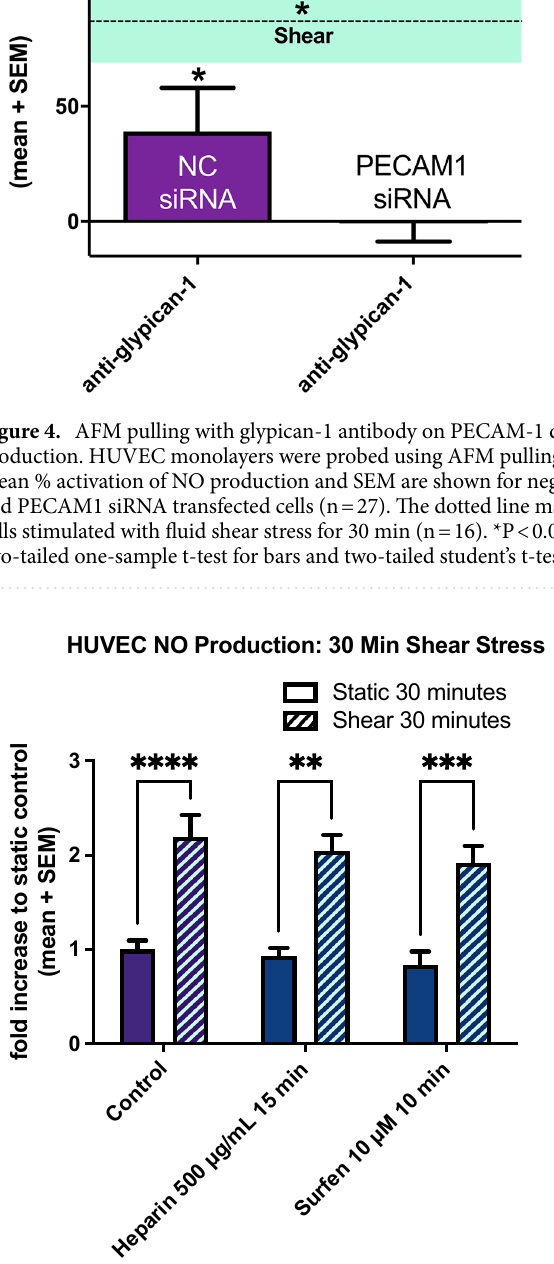
Figure 5. Heparin and Surfen treatment does not affect shear-induced NO production at 30 min in HUVEC. Heparin (500 µg/mL) and surfen (10 µM) were used to treat HUVEC 15 min prior to fluid shear stress exposure to block shear-induced HS binding to PECAM-1. DAF-2T levels were normalized to static control levels within each set. From left to right, n = 17, 22, 8, 15, 12, 16. *P < 0.05 using one-way ANOVA followed by Sidak’s multiple comparisons